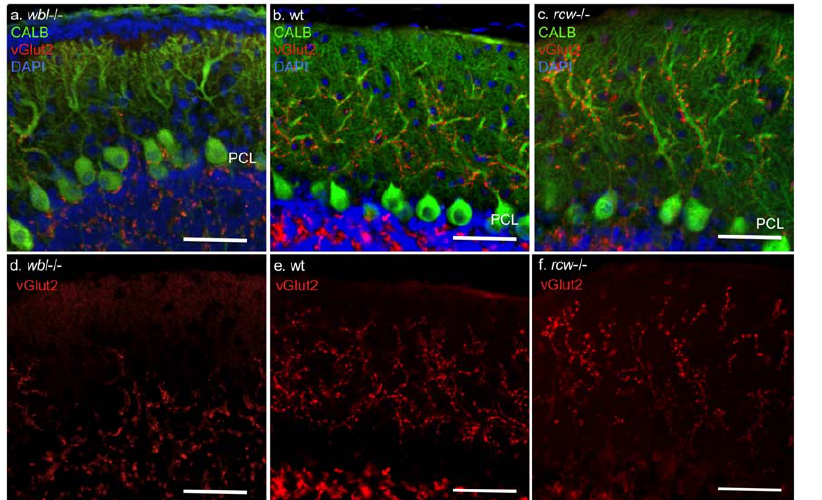
Figure 6. Climbing fibers are reduced in late stage Inpp4a wbl mutants. Panel a shows the Inpp4a wbl mutant at age P24, Purkinje cells are labeled with anti-calbindin (green) while climbing fibers are labeled by anti-vGlut2 (red). Panels b and c show wild-type control and Grm1 rcw mutant for comparison. Panels d, e and f show climbing fibers in red from the unmerged image. Scale bar indicates 100 microns, (PCL), Purkinje cell layer.